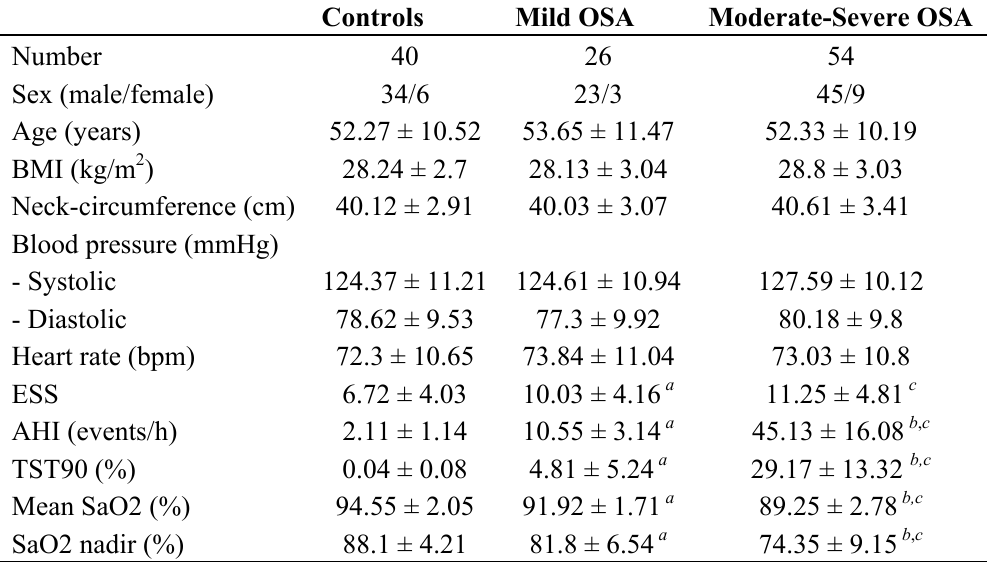
Table 1. Demographic and polygraphic characteristics of study population. Controls Mild OSA Moderate-Severe